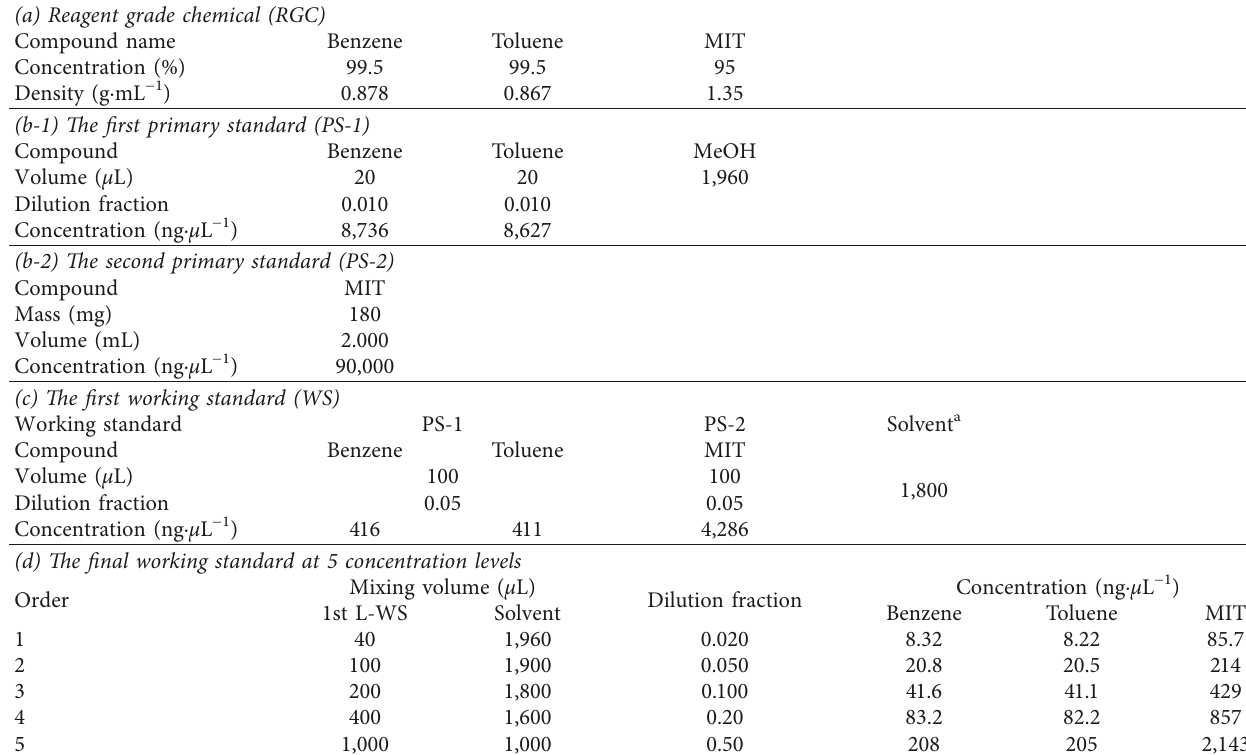
Figure 1: A plot of the experimental sequence for the preparation and analysis of the working standards (WSs). (a) Preparation of working standards. (b) Analysis of the working standards. Table 2: Preparation of working standards (WSs) containing three target compounds (benzene, toluene, and MIT) based on four different solvents (MeOH, DMSO, hexane, and